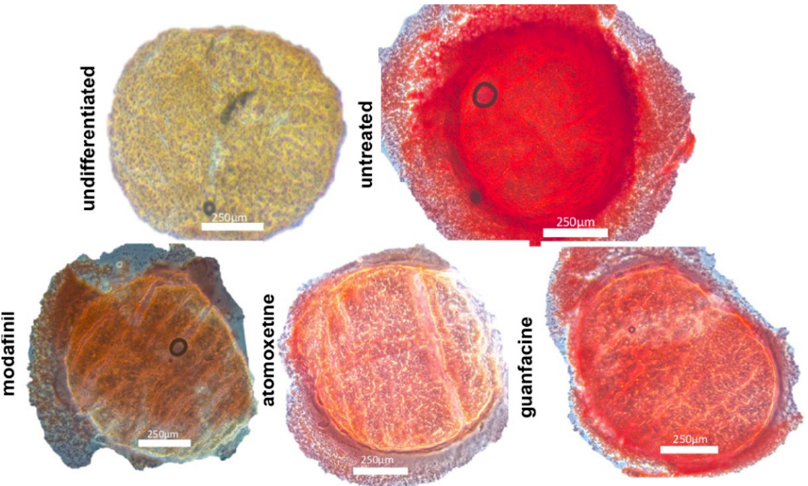
Figure 6. Osteogenic differentiation of mesenchymal stem cell spheroids for 28 days. Alizarin red stained images of untreated, modafinil (11.2 µg/mL)-, atomoxetine (0.9 µg/mL)- and guanfacine- (17.7 ng/mL) treated osteogenic spheroids. Three independent experiments with six biological rep- licates were carried out. Alizarin red (A) stained images of untreated, modafinil- (11.2 µg/mL), atomoxetine- (0.9 µg/mL) and guanfacine (17.7 ng/mL)- treated MG63 spheroids. Three independ- ent experiments with six biological replicates were carried out. Scale bar 250 µm.